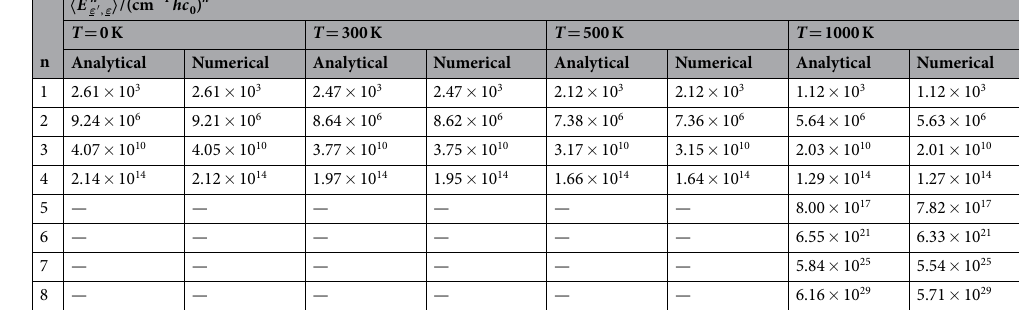
Table 1. Analytically and numerically computed moments. 4.51 × 10 4 cm − 2 ( hc 0 ) 2 is added to the second moments to take the Gaussian line shape function (FWHM = 500 cm − 1 ) into account; see ref. 29 for details. A time increment of 0.10 fs is used for computing the numerical derivatives.